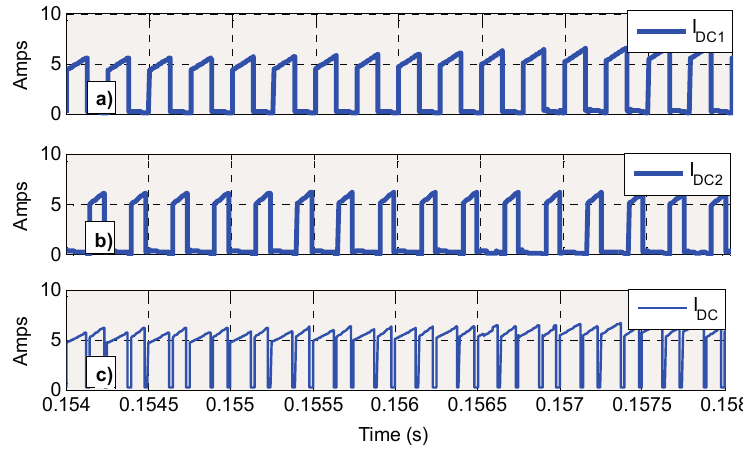
Figure 9. Current waveforms ( a ) I DC 1 , ( b ) I DC 2 , and ( c ) I DC